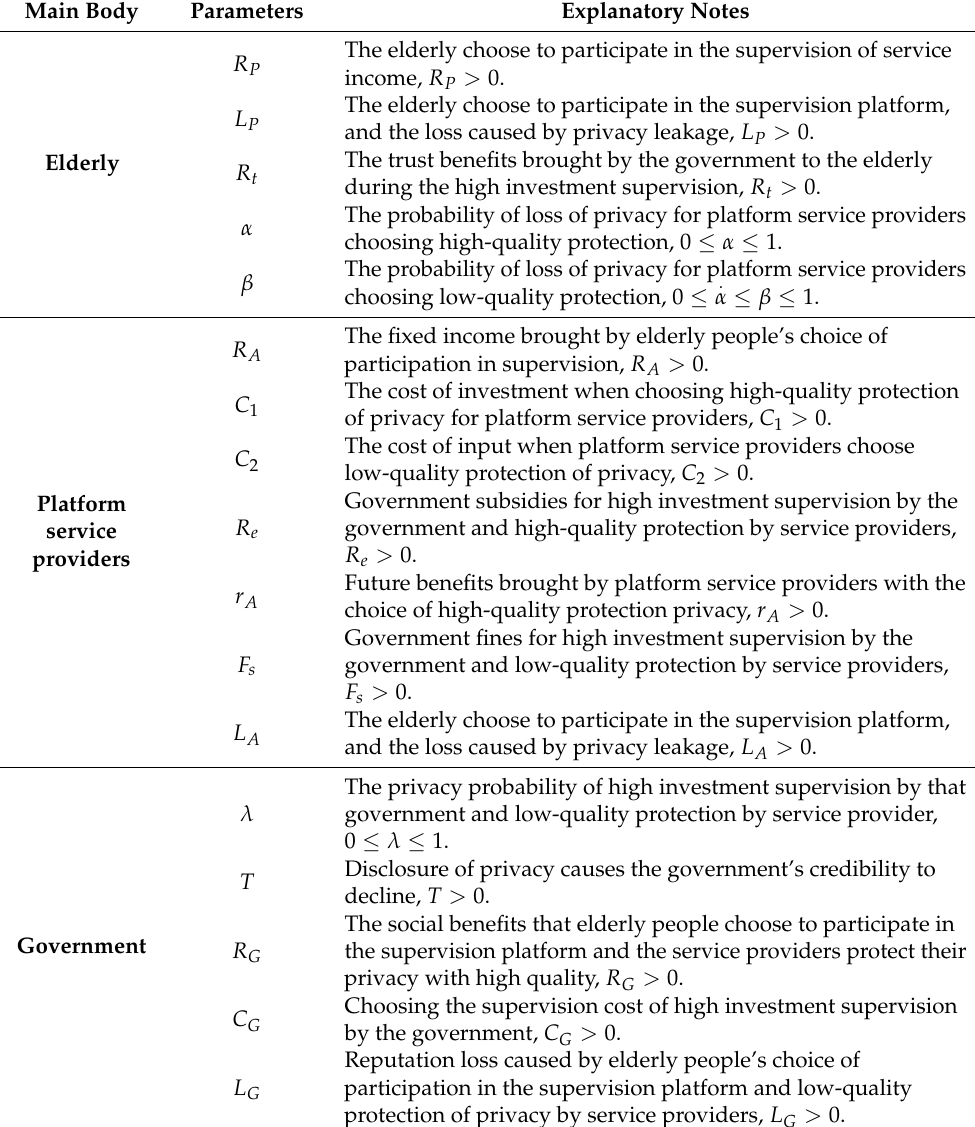
Table 1. Main body parameters.